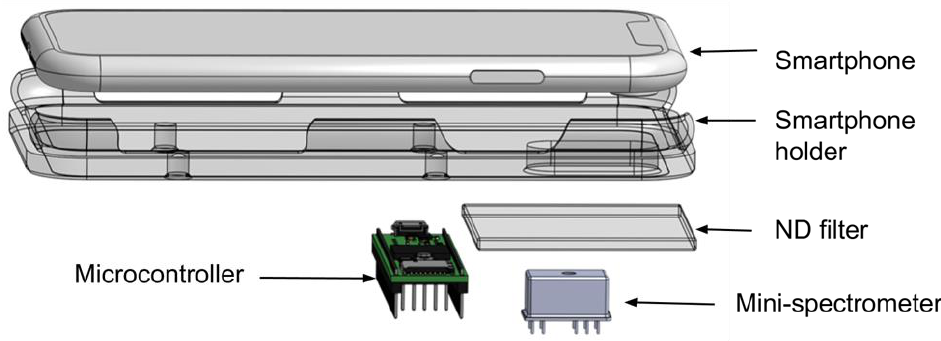
Figure 1. Exploded view of the smartphone flash spectrometer. The device is comprised of a smartphone adapter, neutral density filters (total optical density 4 OD, Newport), a micro-spectrometer C12880MA (Hamamatsu), a microcontroller (Teensy 3.6, 32 bit 180 MHz ARM Cortex-M4 processor, PJRC), and a microSD card, and is packed into a 3D-printed enclosure (https://github.com/willsonlab/mini-spectrometer, accessed on 1 September